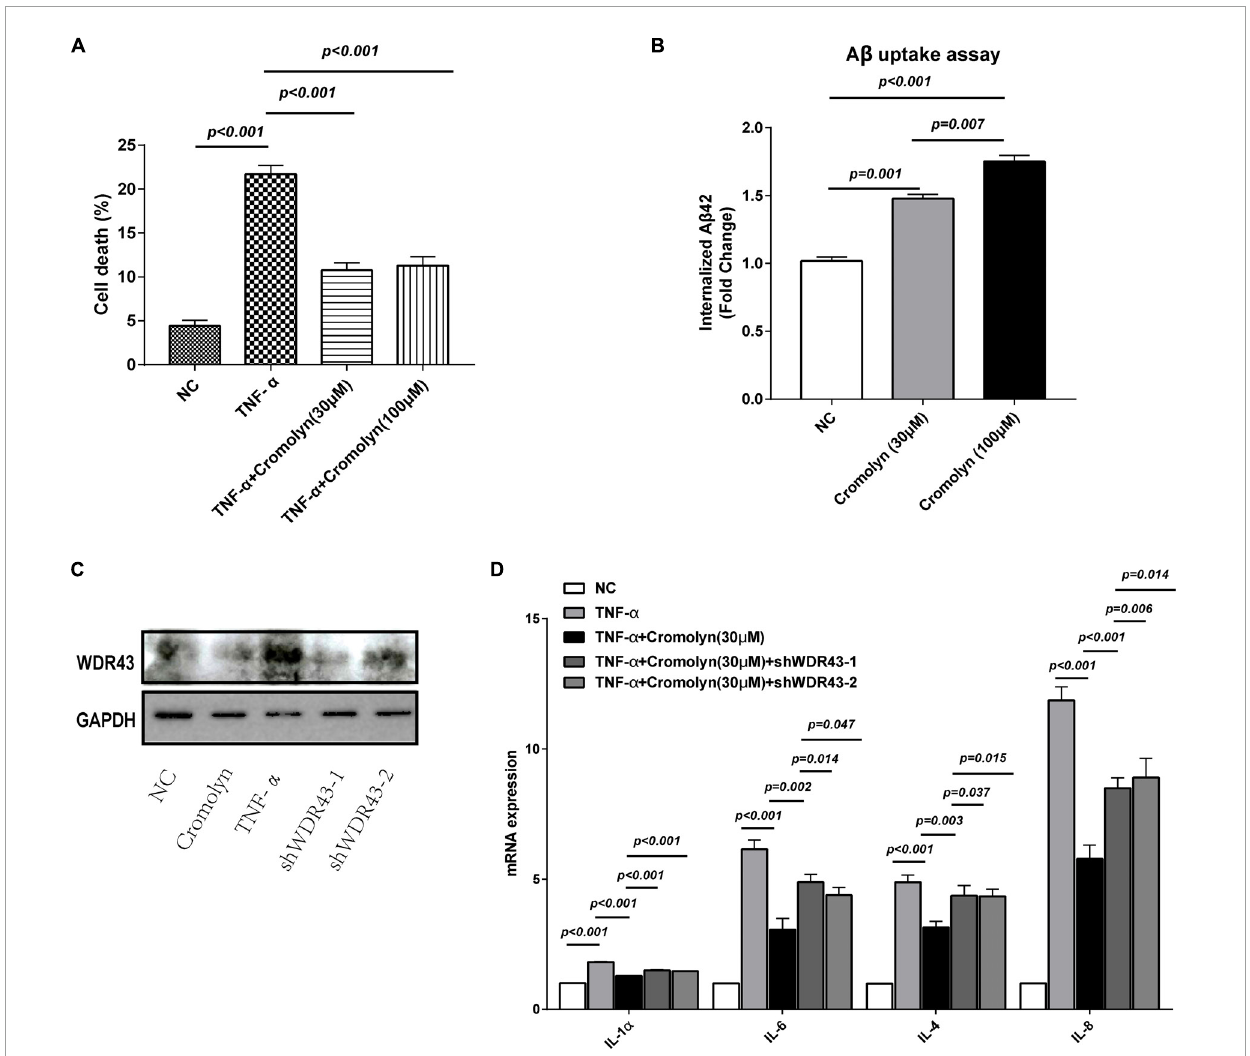
FIGURE6 Cromolyn targets WDR43 to exert anti-inflammatory effects on BV2 cells. (A) Cell viability assay showed that tumor necrosis factor alpha (TNF)- α induced cell death in BV2 cells in a concentration-dependent manner (0, 0.01, 0.03, 0.1, and 0.3 µ g/mL; 24 h). (B) Cromolyn promotes the uptake of A β 42 in BV2 cells: BV2 cells were treated with cromolyn (30 and 100 µ M) for 16 h and subsequently incubated with soluble A β 42 and compounds for 3 h. The cells were collected for ELISA. A β 42 uptake was higher in BV2 cells treated with cromolyn than in control BV2 cells. (C) Western blotting of WDR43 protein extracted from cells treated with cromolyn, TNF- α , shWDR43-1, and shWDR43-2. (D) Bar graph demonstrating the mRNA expression of inflammation-related factors in cells treated with cromolyn, TNF- α , shWDR43-1 and shWDR43-2. Data are expressed as the mean ± SEM ( n = 3; one-way